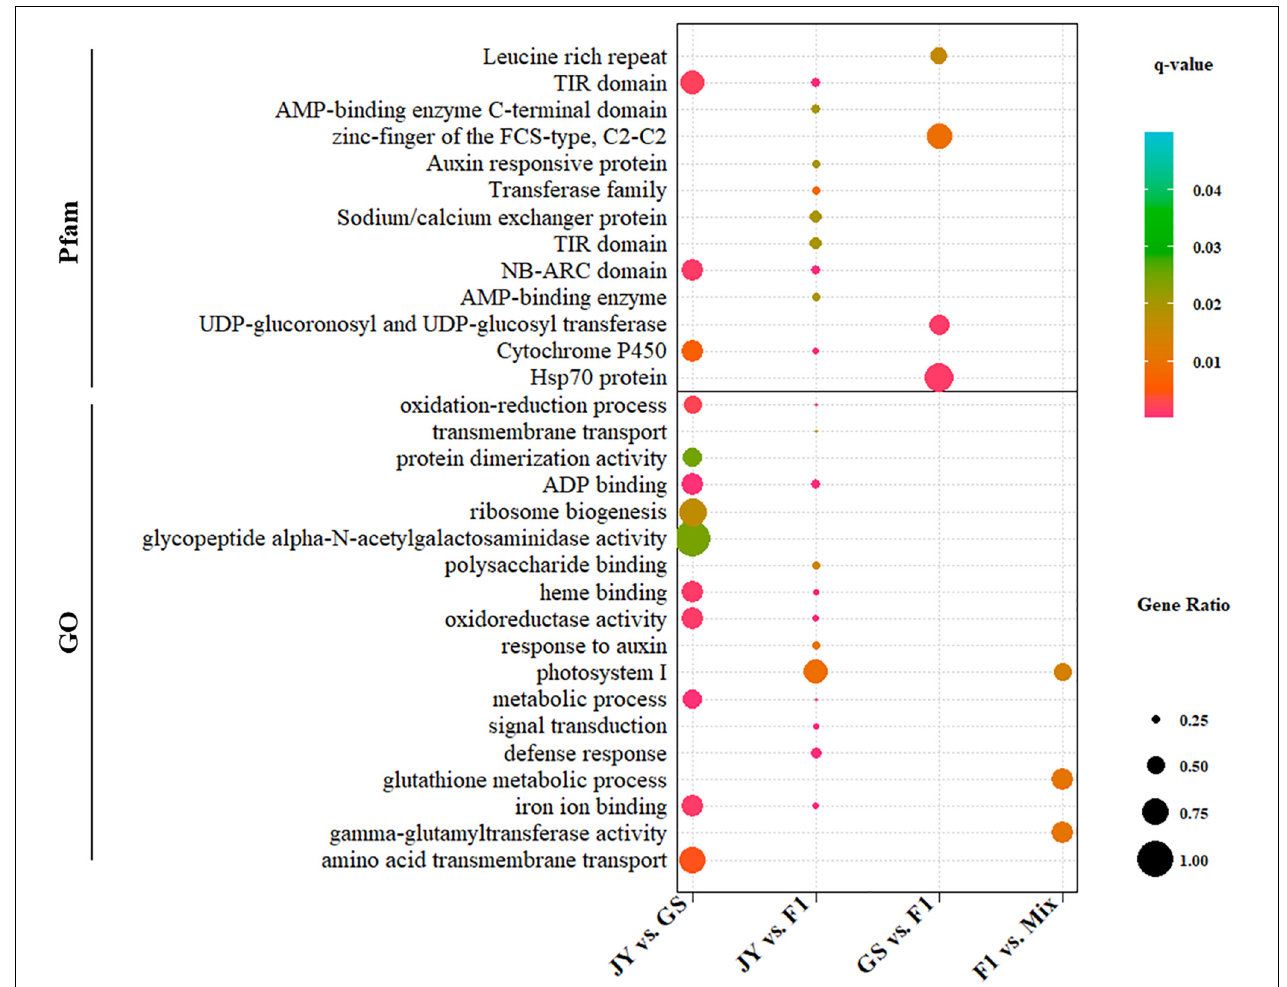
FIGURE 2 | GO and Pfam enrichment of DEGs between genotypes. GO (Gene Ontology) (lower) or Pfam (upper) terms significantly ( q -value < 0.05) that were over-represented in DEGs are shown. The dot size and color correspond to proportions of DEGs and the q